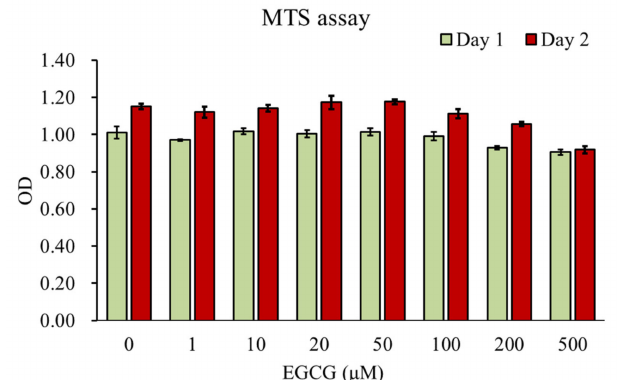
Figure 1. The cell viability of human articular chondrocytes after treatment with EGCG at different concentrations was determined by MTS assay for 24 and 48 h. The columns represent the means ± SE. ( n = 8, ** p < 0.01 vs. the control).